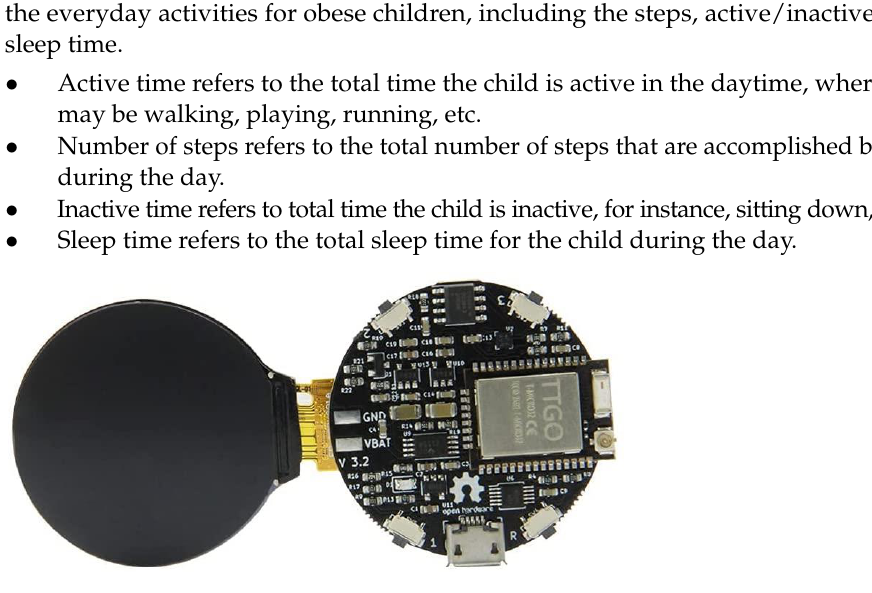
Figure 6. TTGO T-watch with ESP32